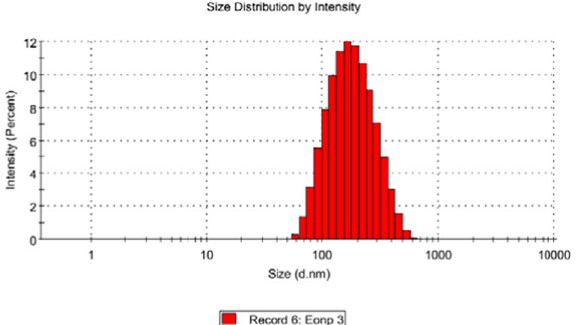
Figure 2. Size distribution by intensity for aqueous H . pineodora essential oil loaded chitosan nanoparticles.